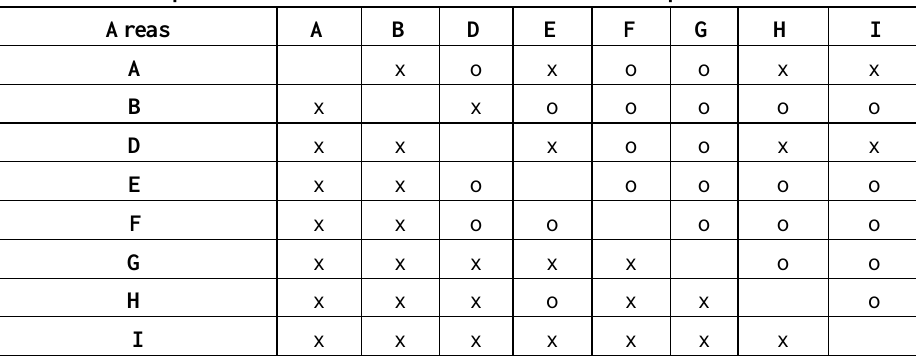
Table 4. Dunn‘s test pairwise comparisons between areas. Upper right table: pairwise comparisons based on species distribution; Lower left table: pairwise comparisons based on daily temperature recorded between 1996–2005. X: the areas are significantly different ( p < 0.05). O: differences are not significant ( p >